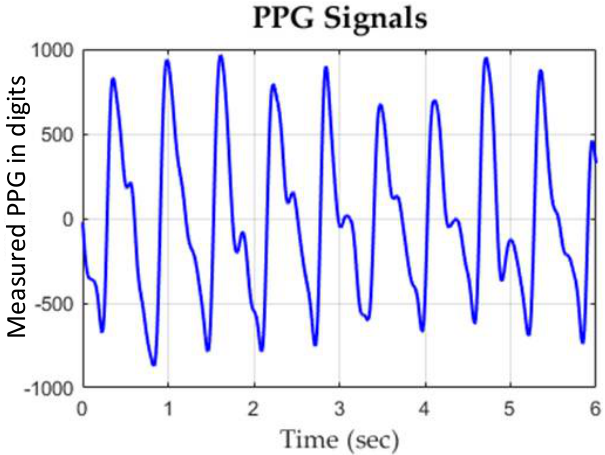
Figure 7. A typical experimental PPG waveform measured by the proposed PPG sensor. Table 2. The confusion matrix for assessing DOS.